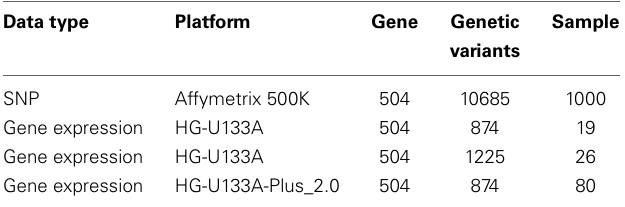
Table 2 | A summary of four datasets from different levels and platforms used in this analysis.